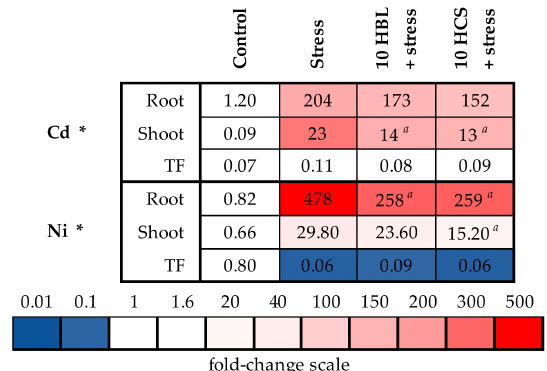
Figure 6. The effects of heavy metal stress and treatment with brassinosteroids on the content of cadmium and nickel ions ( µ g/g dry weight) and translocation factors in barley plants. The value in the control plants was taken as 1.0, the relative decrease is indicated in blue, the relative increase is indicated in red. TF—translocation factor. Asterisks (*) indicate significant differences from the control variant, and the a letter indicates significant differences from the polymetallic stress-treated variant ( p < 0.05).